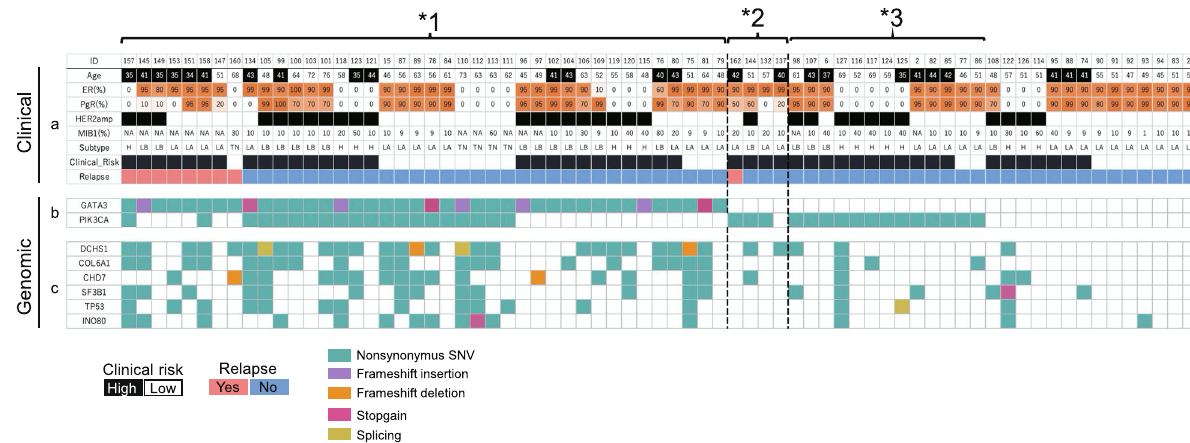
Fig. 2 Validation of clinicopathological and genomic risk factors via targeted deep sequencing. a The clinical information included age; percentages of estrogen receptor (ER) − , progesterone receptor (PgR) − , and MIB1-positive cells according to immunohistochemistry (IHC); human epidermal growth factor receptor 2 ( HER2 ) expression status; and relapse status. Patients were subdivided into molecular phenotypes using IHC surrogates (luminal A [ER − /PR + /HER2 − ], luminal B [ER + /PR + /HER2 + or ER + /PR + /HER2 − /MIB1 index high], HER2 [in fi gure, shown as H; ER − /PR − /HER2 + ], and TN [ER − /PR − /HER2 − ]). Clinical risk estimated by age and HER2 expression status is shown. b GATA3 and PIK3CA mutations are shown (red and blue, respectively). Only the results for nonsynonymous mutations are presented. In total, 40 of 72 (56%) patients carried nonsynonymous GATA3 mutations. Nonsynonymous PIK3CA mutations were detected in 36 of 72 (50%) patients. c The genes that overlapped among patients in the discovery cohort are shown. *1: GATA3 mutation-positive ductal carcinoma in situ (DCIS). *2: GATA3 mutation-negative, ER-positive DCIS with low PgR expression. *3: PIK3CA mutation-positive DCIS that does not satisfy *1 or